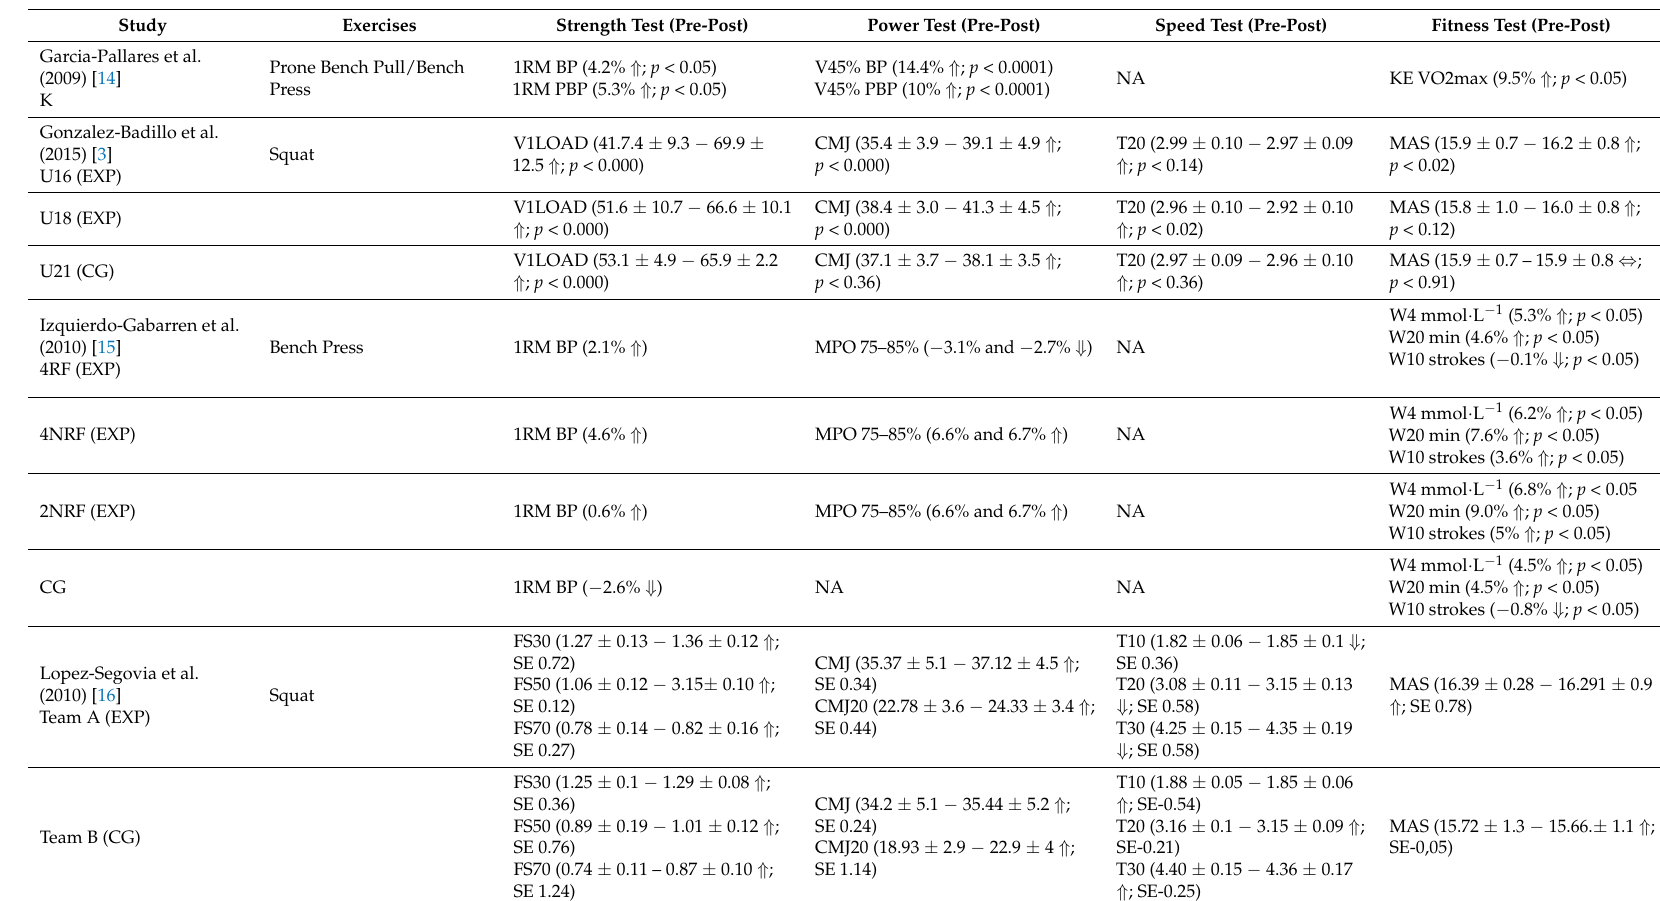
Table 2. Overview of the